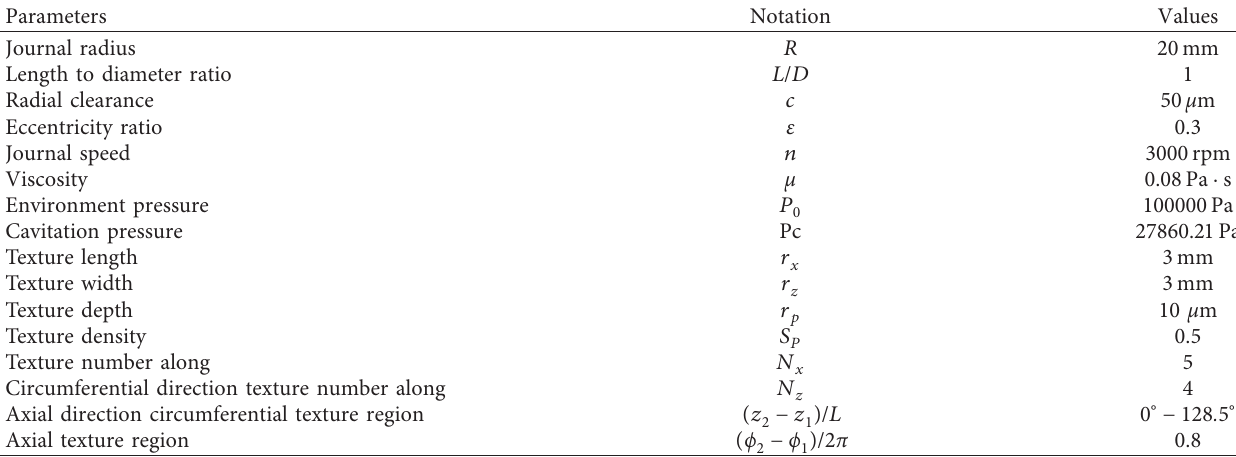
Table 1: Geometrical and texturing parameters for the studied textured journal bearing.